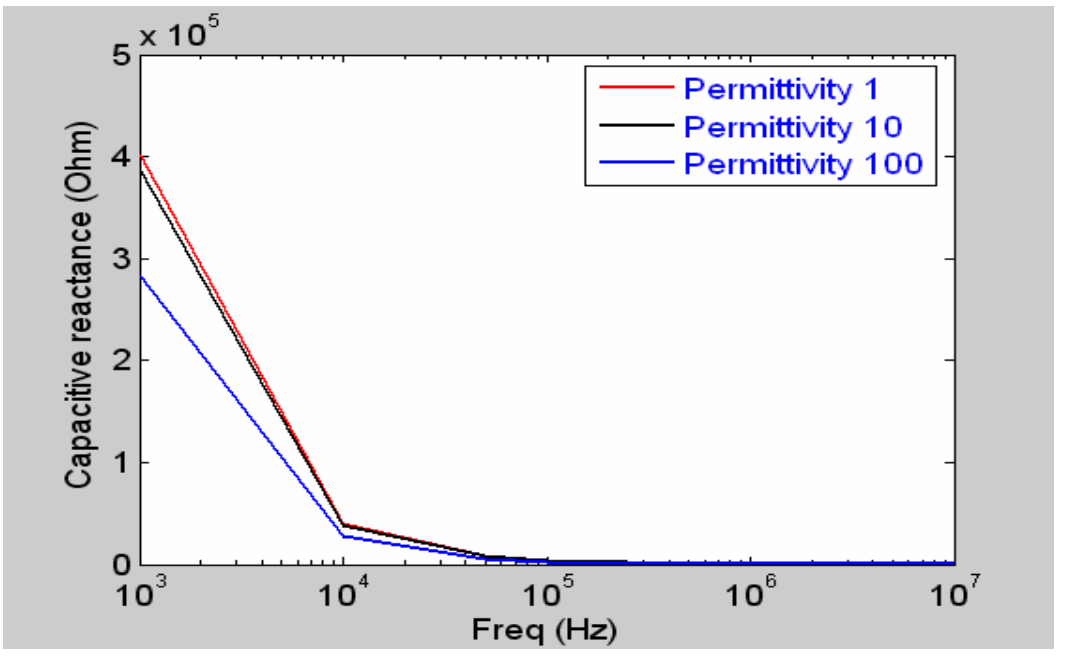
Figure 17. Variation of reactance with